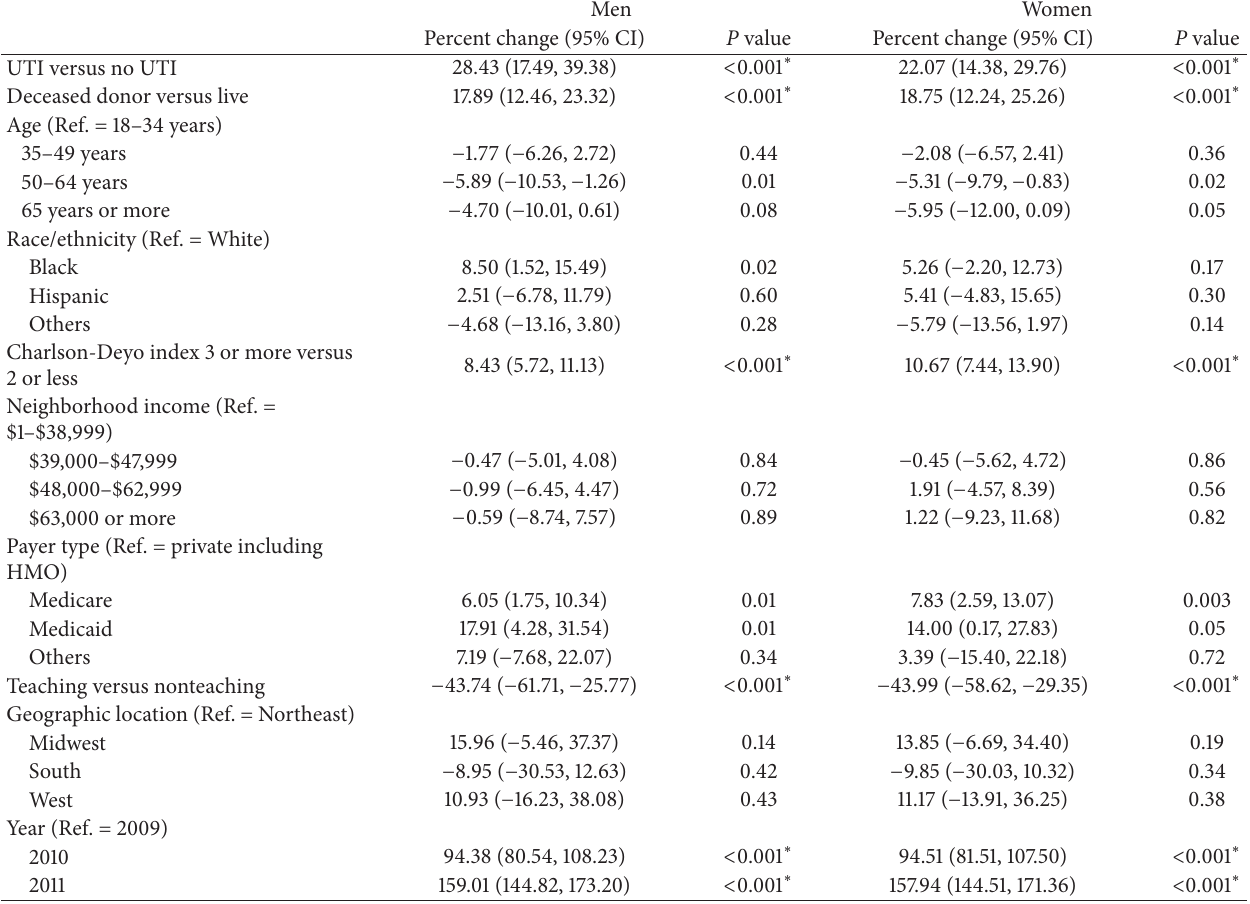
Table 3: Multiple linear regression for percent change in total charges in dollars (and 95% CI) among renal transplant recipients, NIS